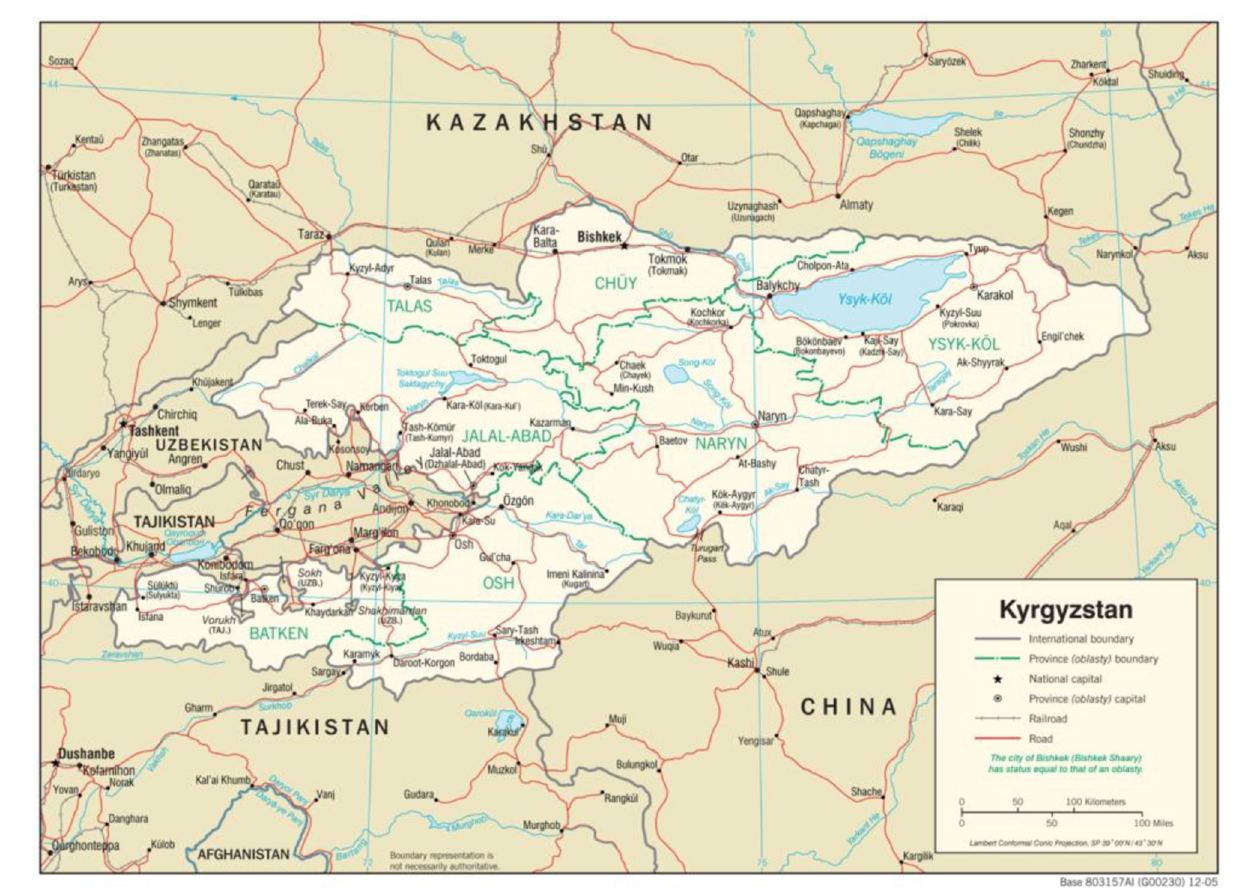
FIGURE 2 | Political map of Kyrgyzstan, showing its proximity to Kazakhstan and Tajikistan. The major cities mentioned in the text are shown (Almaty, Bishkek, Osh and Dushanbe). Map courtesy of the University of Texas Libraries